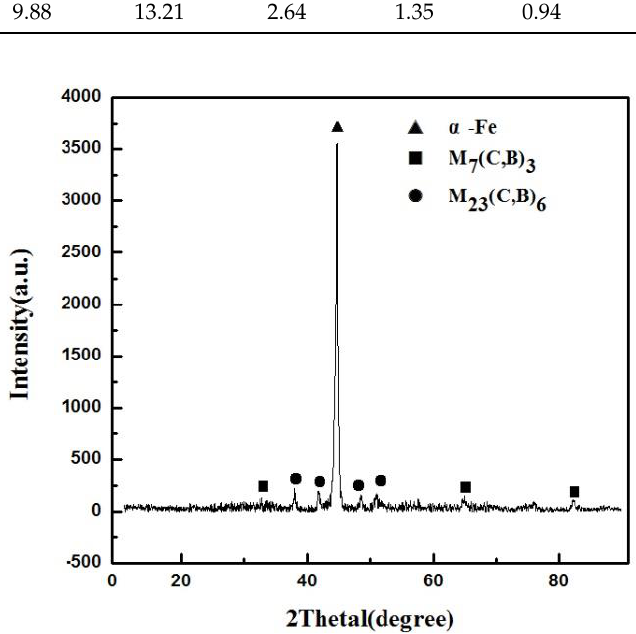
Figure 11. XRD result of B-bearing high-speed alloy steel after tempering.